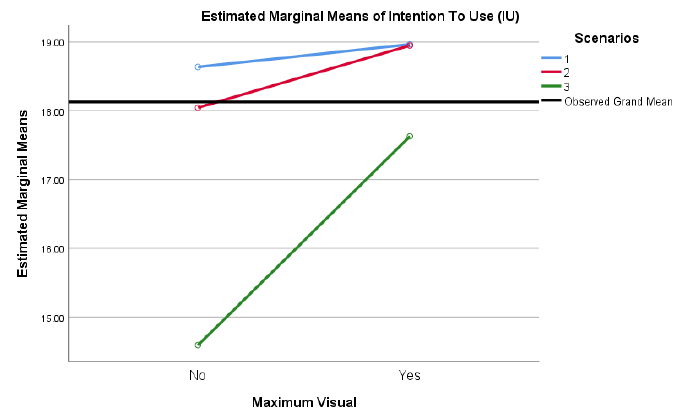
Figure 9. Estimated marginal means—intention to use (IU).